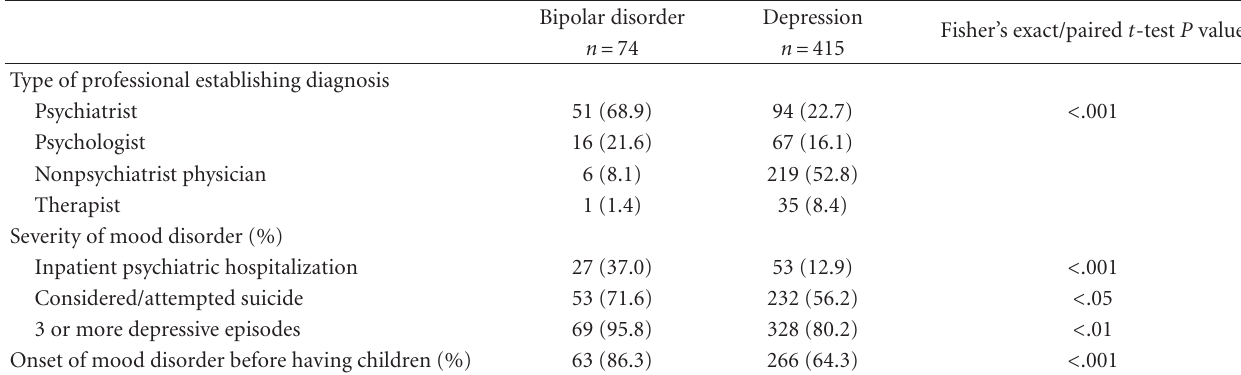
Table 2: Self-reported clinical characteristics of mothers of children with an autism spectrum disorder and reported professional diagnosis of mood disorders ( n = 489).